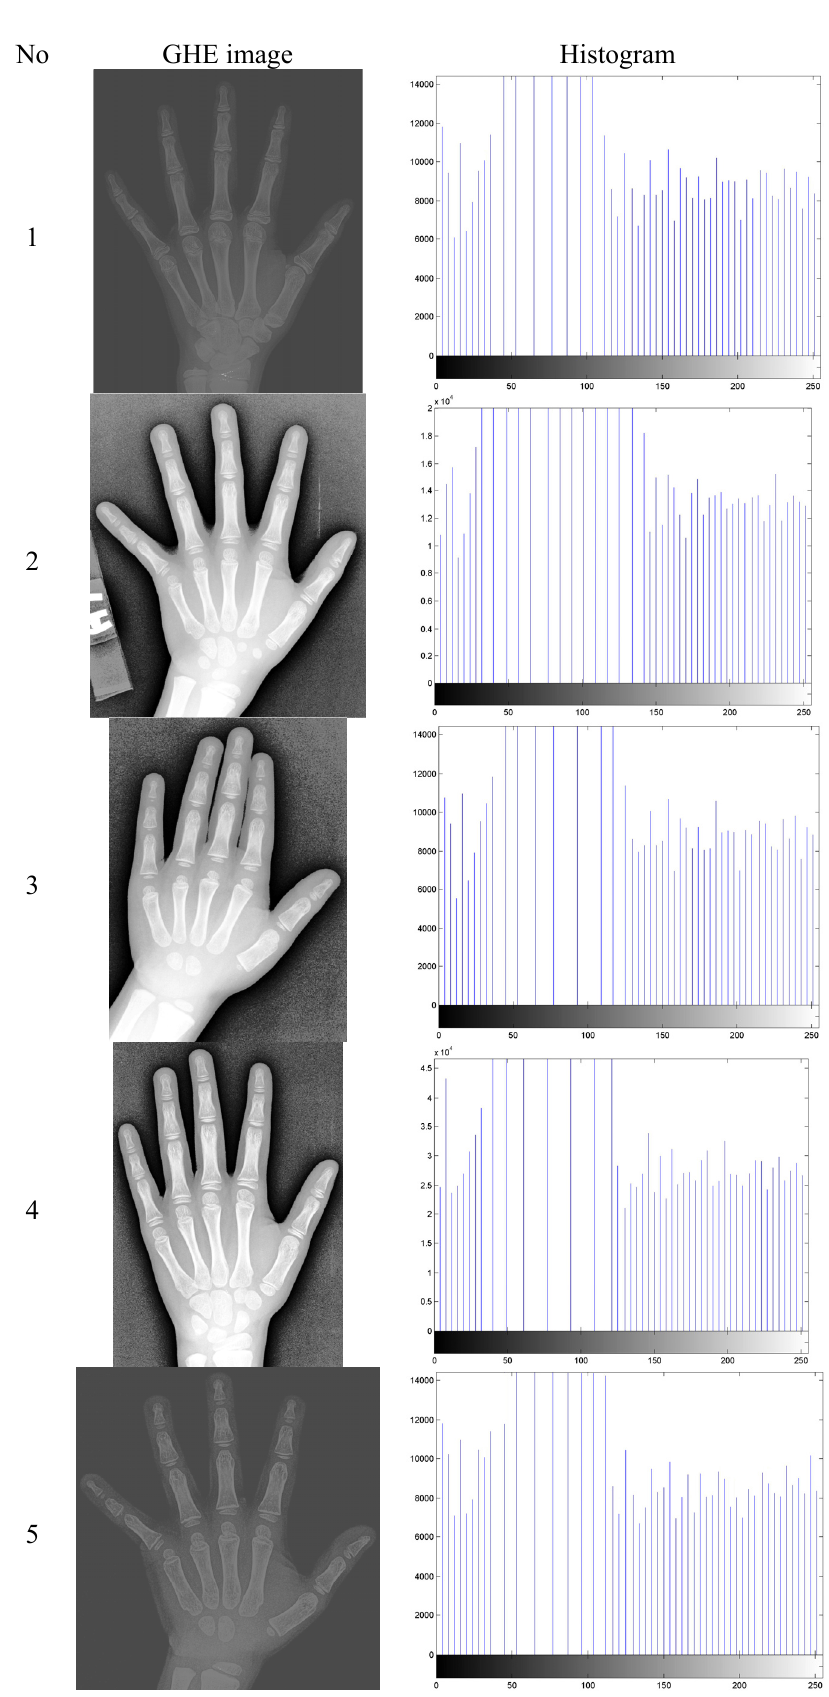
Figure 2. The output images and their histograms (global histogram equalization (GHE)). No GHE image Histogram